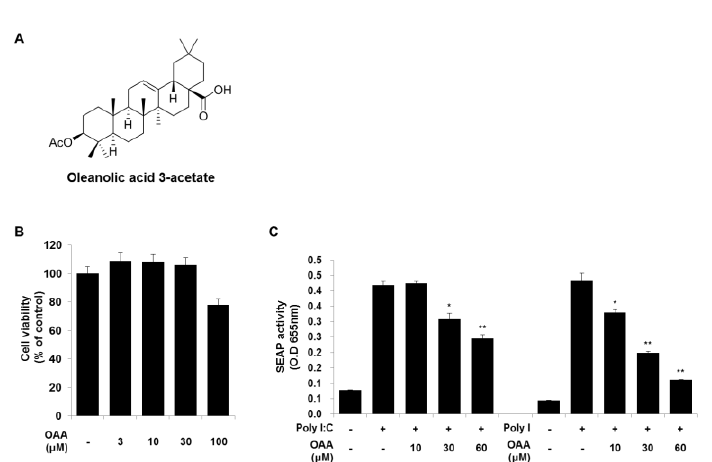
Figure 1. OAA inhibits poly(I)-induced NF- κ B / AP-1 activation and cytokine expression in human